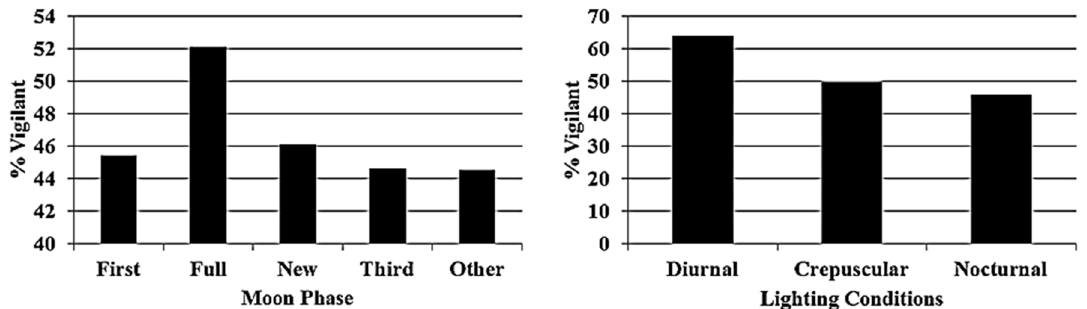
Figure 2. Raccoons were more vigilant at baited sites during full moon and diurnal hours. The “other” moon phase corresponded to days outside the 5 ‐ day window around each named phase. We defined crepuscular lighting conditions as being within 1 h of sunrise or sunset.